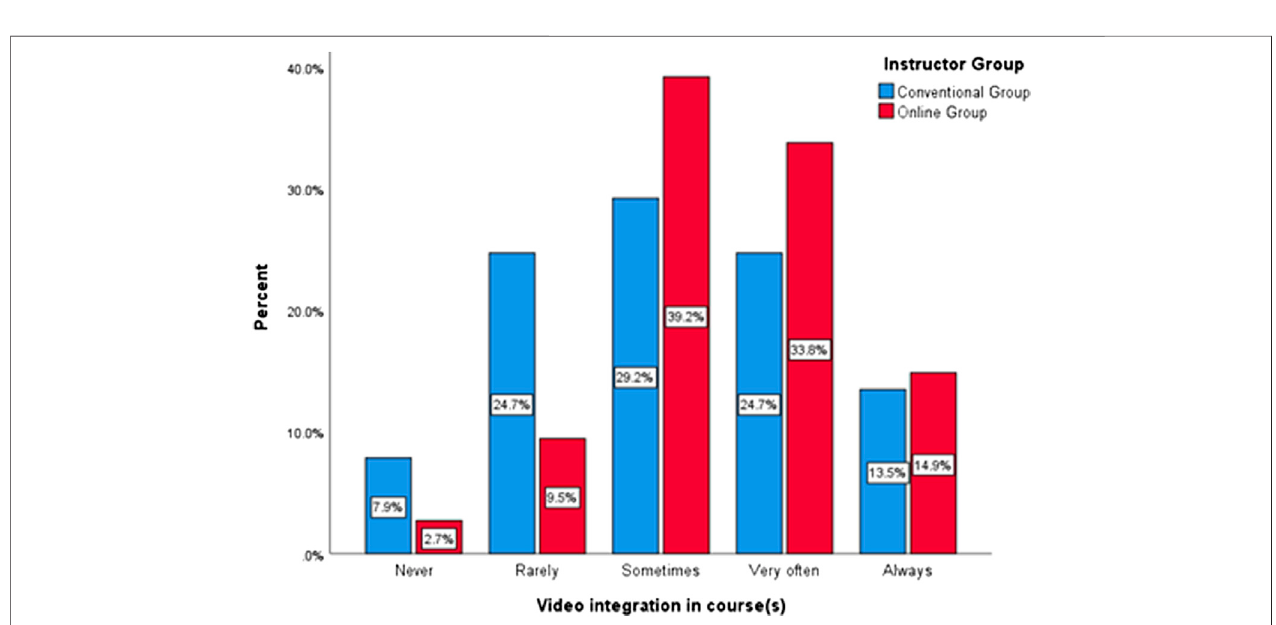
FIGURE 7 | Level of instructional usage of